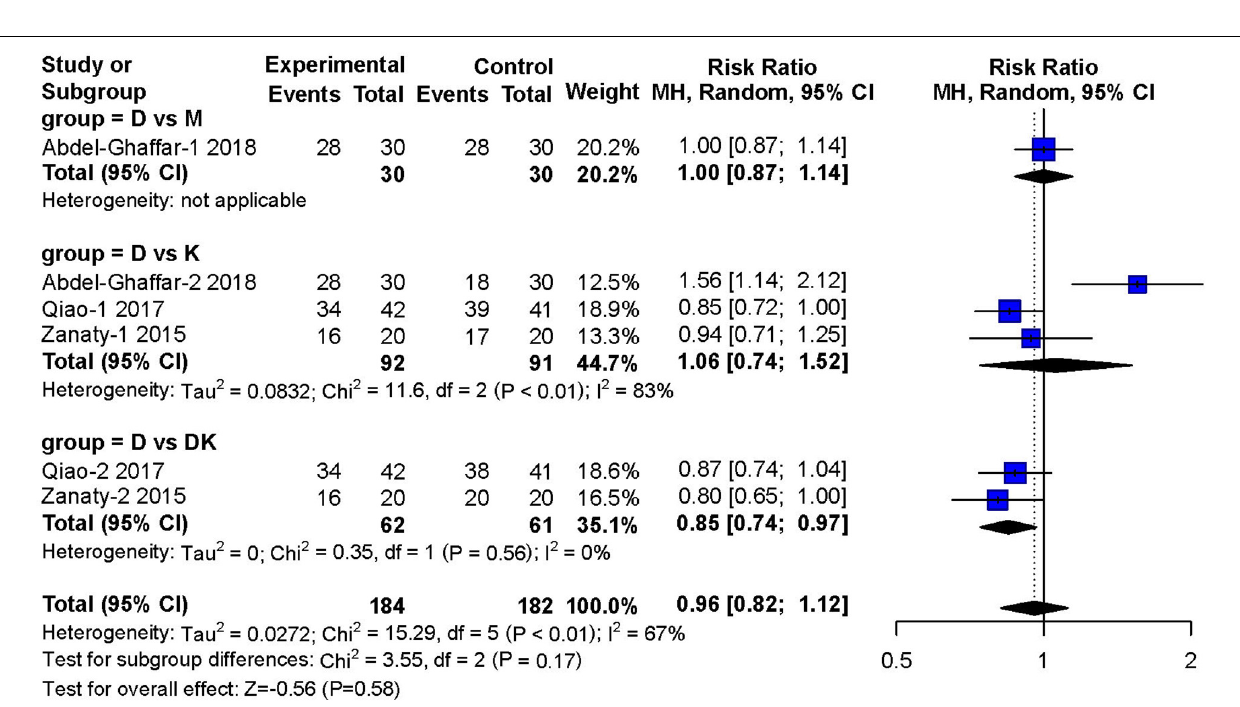
FIGURE 6 | Meta-analysis of nebulized dexmedetomidine for satisfactory separation from parents.CI, confidence interval; df, degress of freedom; M-H,